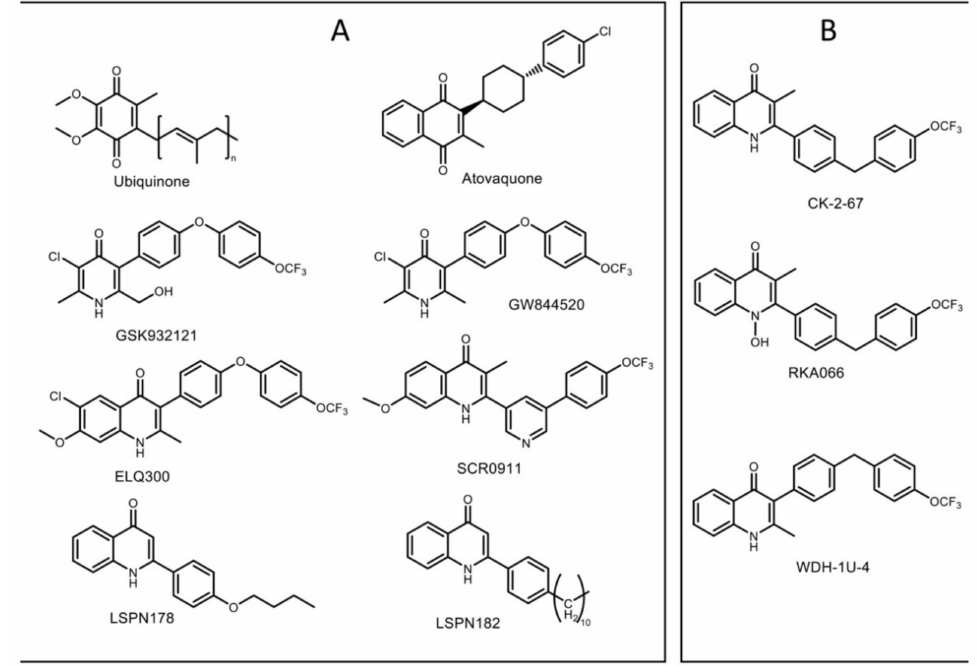
Figure 1. Chemical structures of cytochrome bc 1 ligands. ( A ) Ubiquinone, a native substrate that binds to both Q o and Q i sites of cytochrome bc 1 ; atovaquone, a hydroxy-naphthoquinone targeting the Q o site; GSK932121 and GW844520, 4(1H)-pyridone-based compounds developed by GlaxoSmithKline; quinolone-based compounds ELQ300 and SCR0911, lead antimalarial compounds; LSPN 178 and LSPN 182, modified 2-quinolone that inhibits both stages of the parasite; ( B ) CK-2–67, RKA066, and WDH-1U-4 were the 4(1H)-quinolone-based compounds that were co-crystallized with bovine cytochrome bc 1 in this